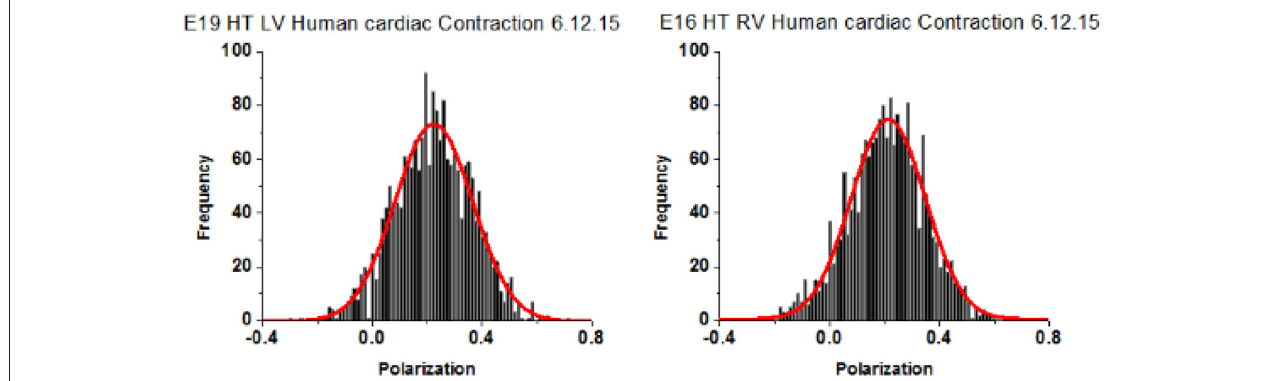
FIGURE 6 | Spatial distribution of lever arm angles of cross-bridges of contracting HF ventricles. The orientation of ∼ 6 cross-bridges in 27 different preparations of LV and 26 preparations of RV Data shows no difference in FWHM. Bars are data. Red line is the best fit.